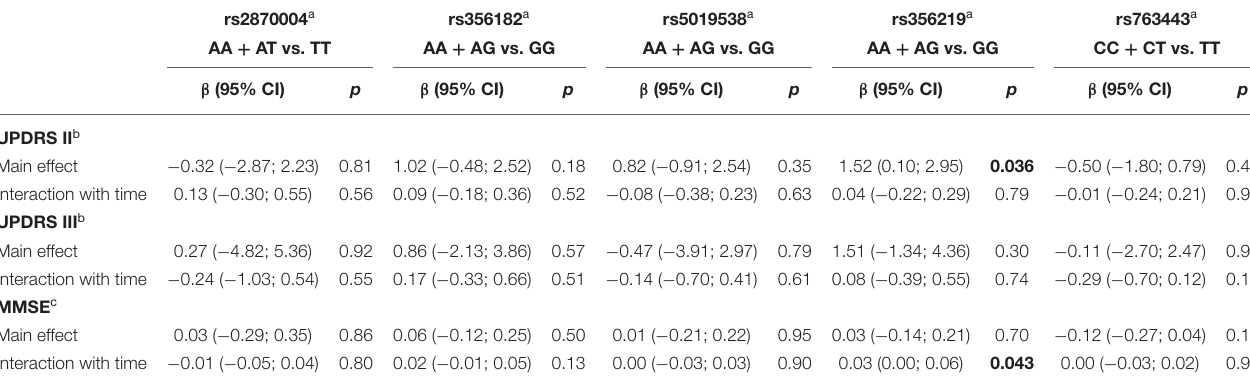
TABLE 3 | Association between annual change in clinical assessments of PD and SNCA polymorphisms assuming a recessive model.